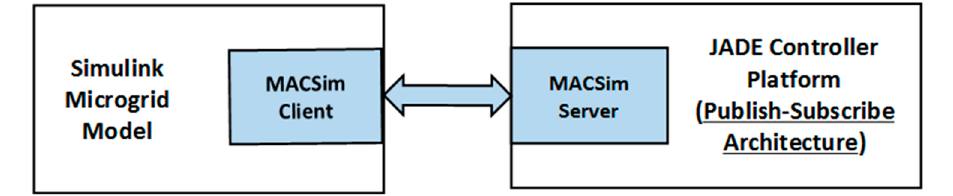
Figure 7. Structure of MACSim toolbox.